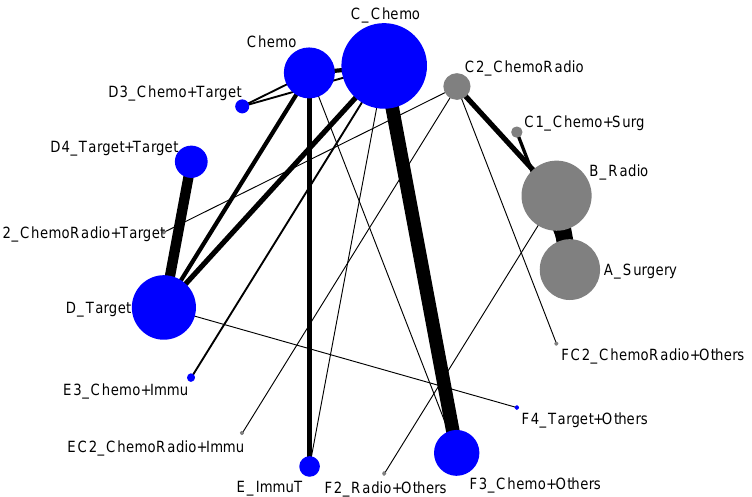
Figure 2. Network map of response rate/disease-free control (all treatment groups), blue is compo- nent I, and gray is component II.